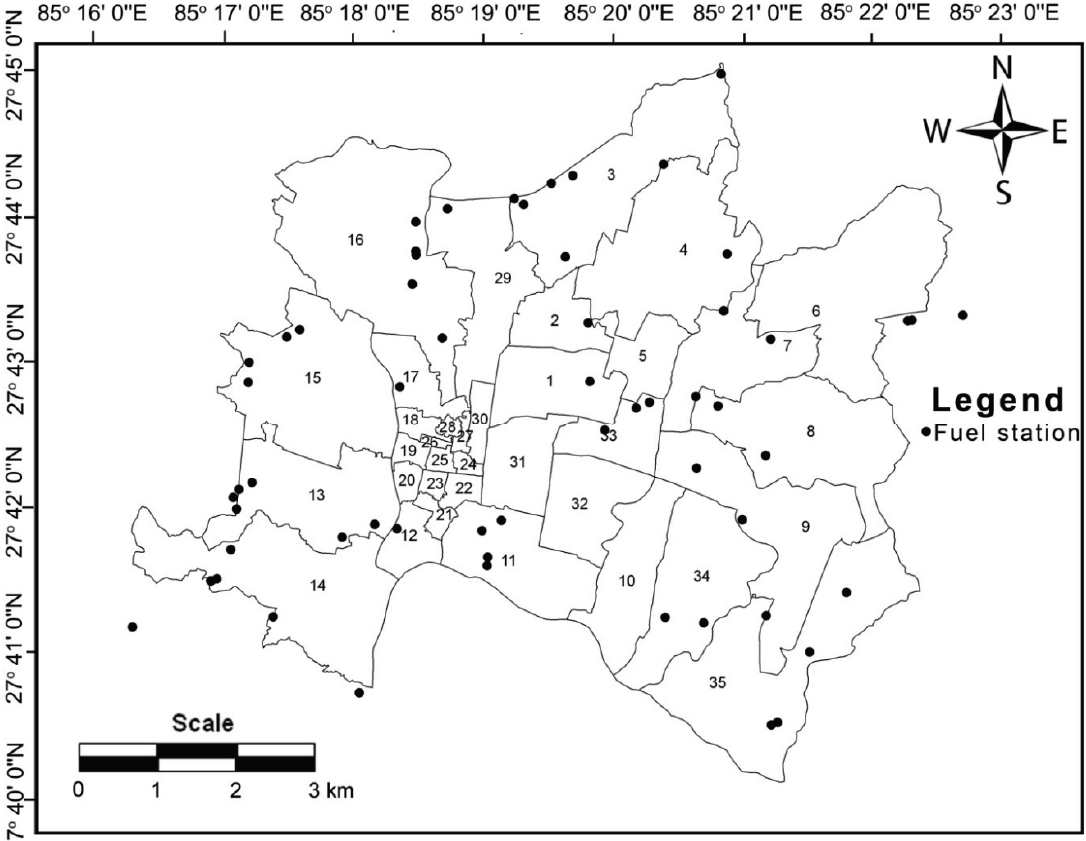
Figure 2. Map showing 35 wards of Kathmandu Metropolitan City with location of fuel